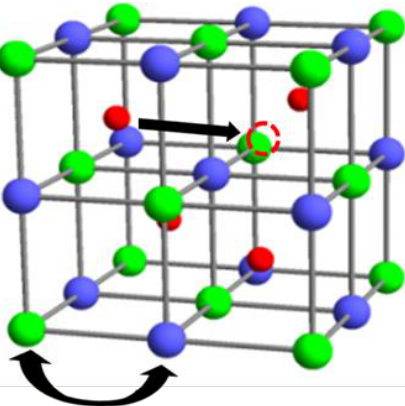
Figure 2. Unit cell of Hf ( • ) Sn ( • ) Ni ( • ). Antisite disorder includes occupancy of supposedly vacant fcc site by Ni and atom swap between Sn and Hf.